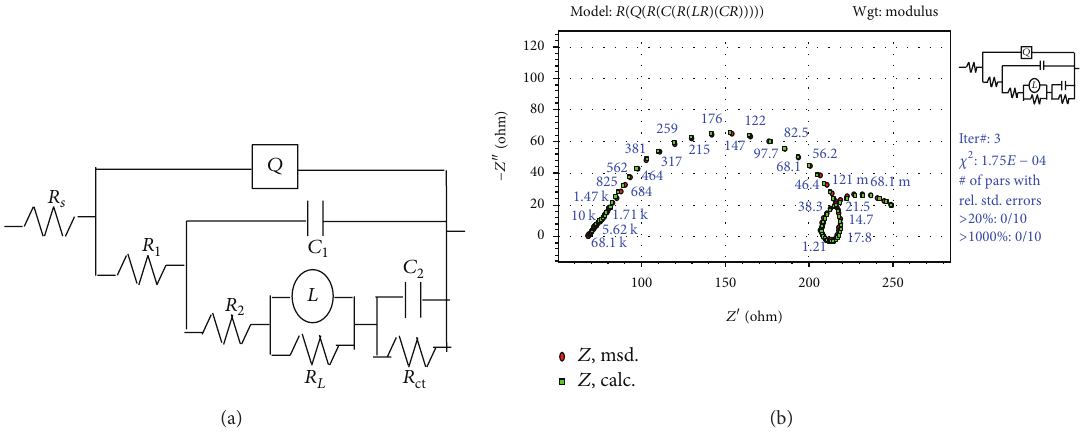
Figure 4: (a) Equivalent circuit used to fit the experimental EIS data. (b) EIS data obtained for the corrosion of aluminum specimen in phosphoric acid at 30 ∘ C.